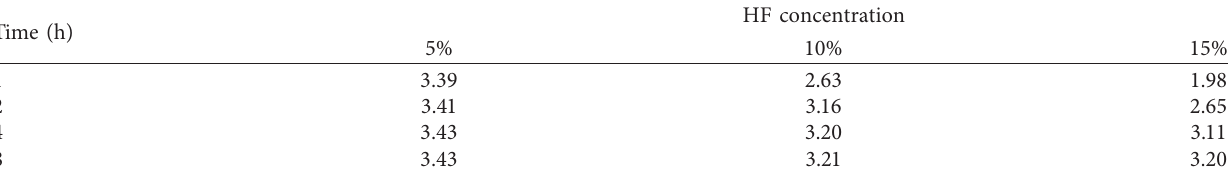
Table 3: Changes in pH of sodium bentonite and different concentrations of HF at different reaction times. Time